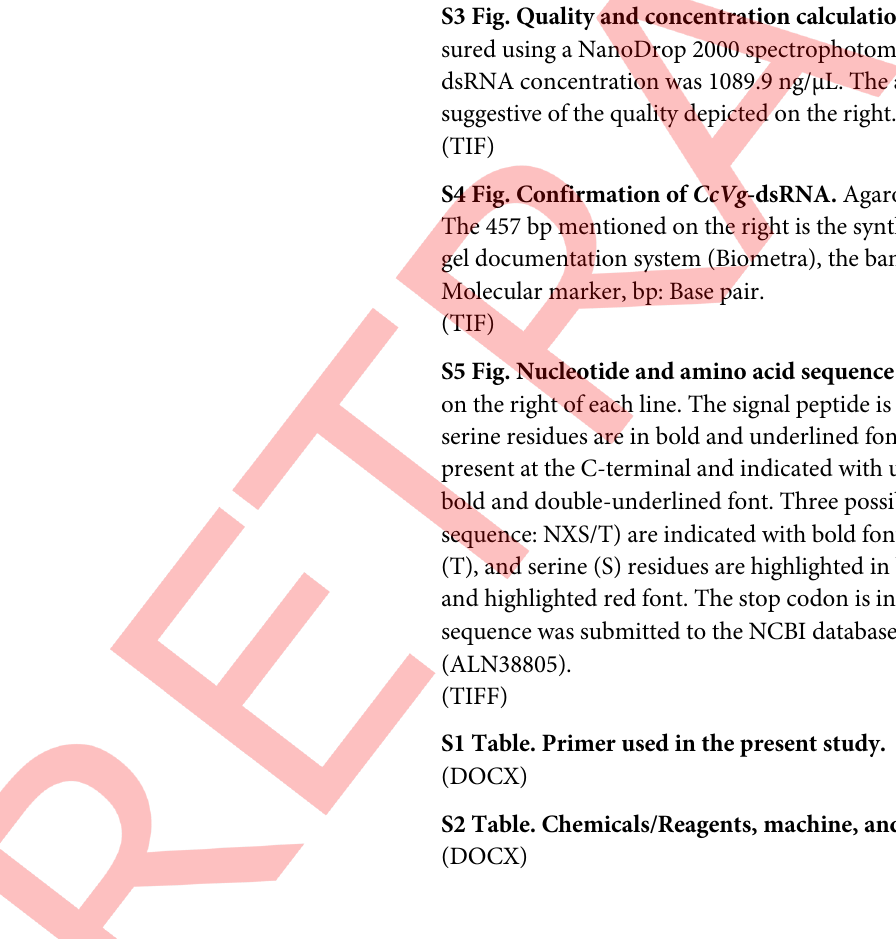
S1 Fig. The PCR-amplified target region of the CcVg gene transcript used for RNAi experi- ments. The 457 bp size mentioned on the right side is the amplified CcVg mRNA template used to synthesize the CcVg -based dsRNA. The amplified band was separated on an agarose gel (1.2%) and visualized under an ultraviolet light through the BioDocAnalyze gel documen- tation system (Biometra). M: Molecular marker, bp: Base pair. S2 Fig. Sequence confirmation of the CcVg -based RNAi target region. Numbers on the right side are nucleotides. The T7 promoter region is in bold and underlined font at the 5´ end. S3 Fig. Quality and concentration calculation of CcVg -dsRNA. The concentration was mea- sured using a NanoDrop 2000 spectrophotometer (Thermo Fisher Scientific, USA). CcVg - dsRNA concentration was 1089.9 ng/ μ L. The absorbance ratio was 2.08 at the 260/280 level, suggestive of the quality depicted on the right. S4 Fig. Confirmation of CcVg -dsRNA. Agarose gel (1.2%) was used to confirm the dsRNA. The 457 bp mentioned on the right is the synthesized CcVg -dsRNA. Using the BioDocAnalyze gel documentation system (Biometra), the band was visualized under ultraviolet light. M: Molecular marker, bp: Base pair. S5 Fig. Nucleotide and amino acid sequence of the CcVg cDNA. Nucleotides are numbered on the right of each line. The signal peptide is indicated by a double underline. The clusters of serine residues are in bold and underlined font. The DGQR and GL/ICG conserved motifs are present at the C-terminal and indicated with underlined font. One cleavage site (RXXR) is in bold and double-underlined font. Three possible glycosylation sites (having a consensus sequence: NXS/T) are indicated with bold font. The phosphorylated tyrosine (Y), threonine (T), and serine (S) residues are highlighted in bright yellow. Six cysteine residues are in bold and highlighted red font. The stop codon is in bold and italic font (small letters). The CcVg sequence was submitted to the NCBI database, and an accession number was obtained (ALN38805).